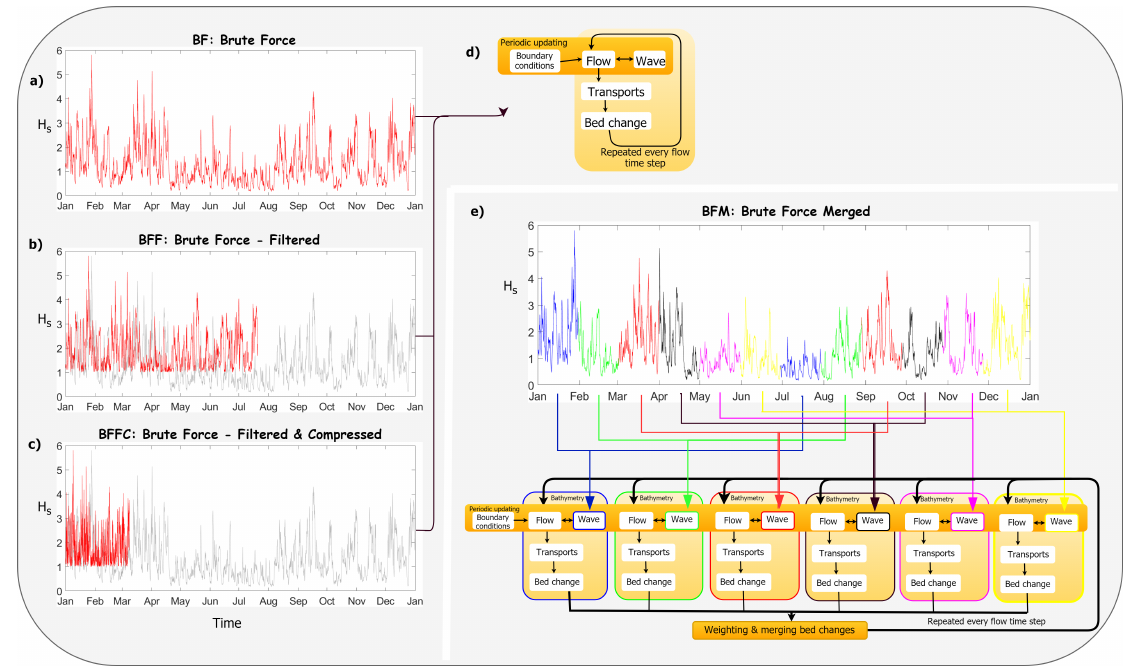
Figure 2. Graphical overview of ( a ) the non-scaled brute force approach (BF) and the three considered morphodynamic acceleration techniques using brute-force time series: ( b ) brute force filtered (BFF), ( c ) brute force-filtered and compressed (BFFC), and ( e ) brute force merged technique (BFM). ( d ) shows the basic morphodynamic feedback loop used in BF, BFF, and BFFC. The red wave time series in ( a – c ) indicate the selected wave time